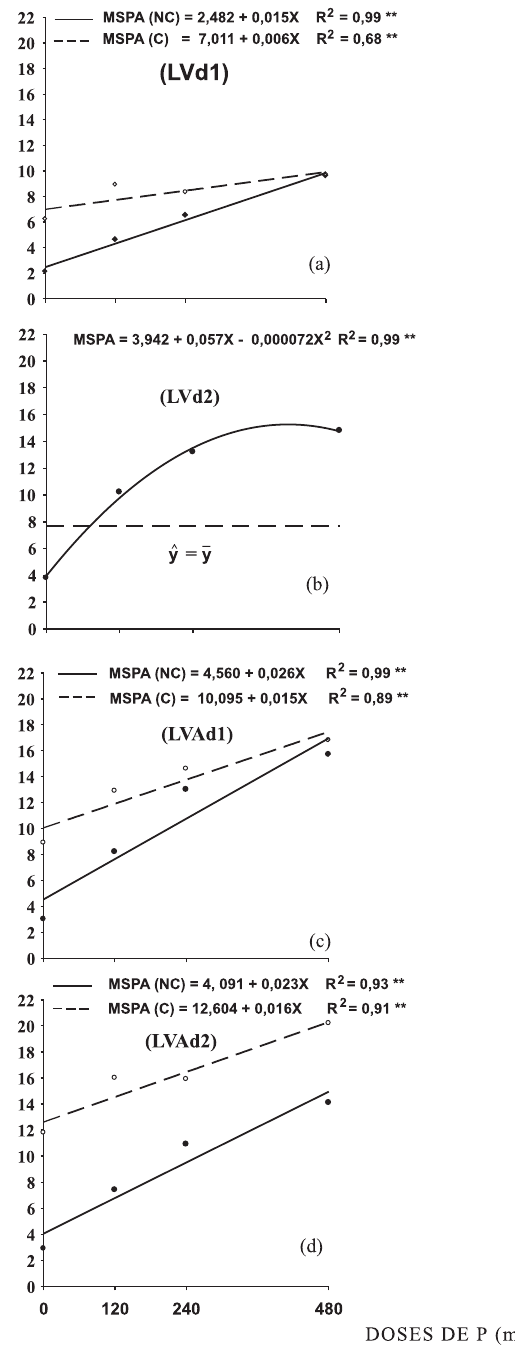
Figura 1. Produção de matéria seca da parte aérea no final do ciclo (MSPA) (a, b, c e d); conteúdo de fósforo na parte aérea no florescimento (CPPA) (e, f, g e h) nos solos LVd1, LVd2, LVAd1 e LVAd2, em função das doses de P, na condição de solo não cultivado (NC) e cultivado